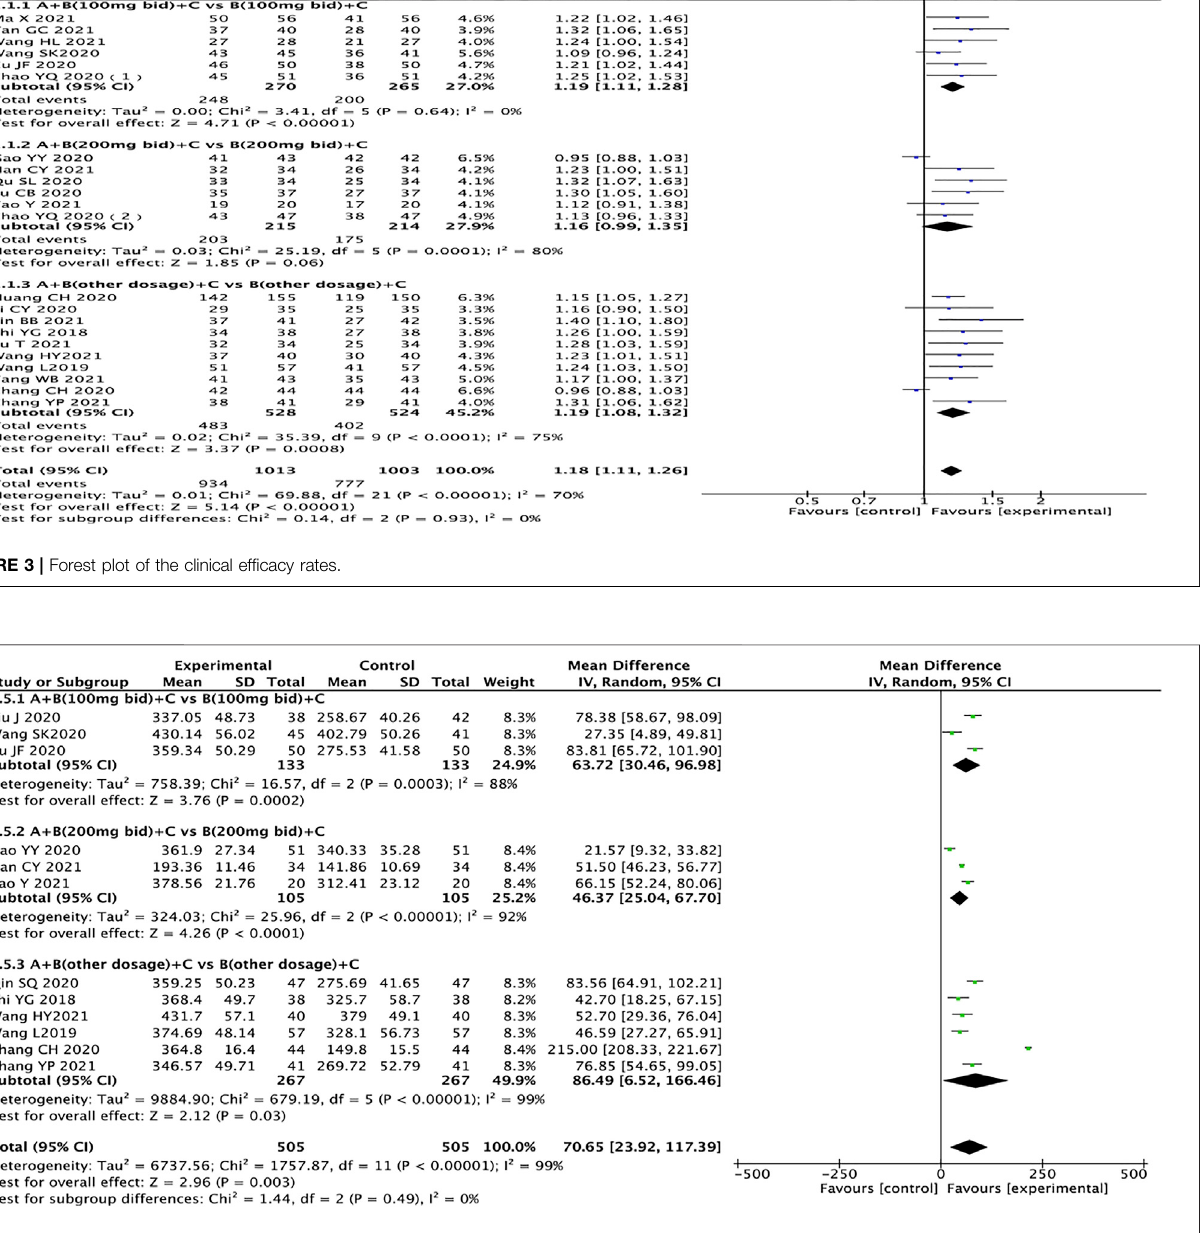
FIGURE 4 | Forest plot of